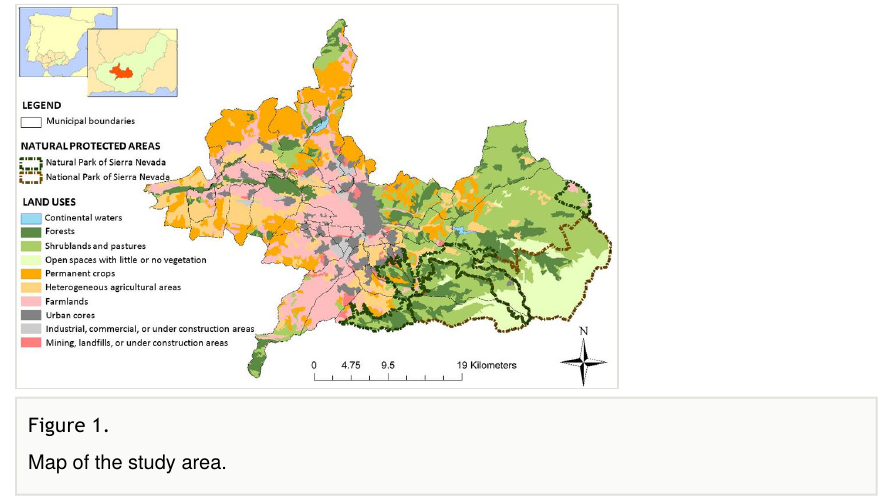
Map of the study